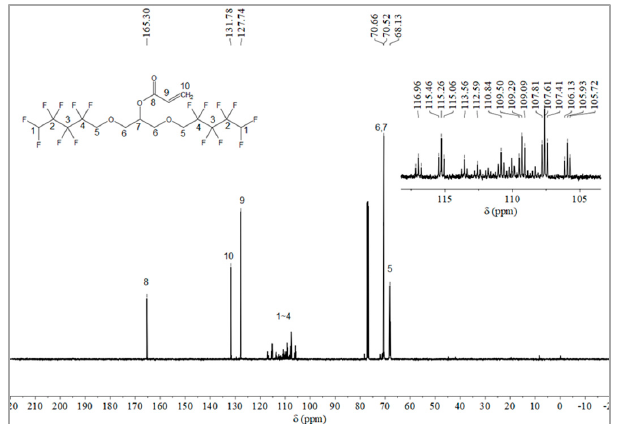
Figure 8. 19 F NMR spectra of OFAE. 2.1.3. Fourier Transform Infrared Spectra Analysis of Water-Repellent Fabric Finishing Agent (OFAE-SA-BA) Fourier transform infrared spectrometry was used to characterize the chemical struc- ture of the fabric fi nishing agent OFAE-SA-BA, and the corresponding FT-IR spectrum was presented in Figure 9. The peaks at 2962–2877 cm − 1 and 1458 cm − 1 were a tt ributed to symmetric stretch and asymmetric stretch of -CH 2 -. The strong peak that appeared at 1734 cm − 1 was a tt ributed to the stretching vibration of carbonyl C=O group. The band at 1250 cm − 1 represented the characteristic peaks of ether C-O-C. The peaks at 1171 cm − 1 and 1129 cm − 1 represented the symmetric vibration mode of -CF 2 -. In conclusion, the results indicate that the target product was indeed the fabric fi nishing agent.